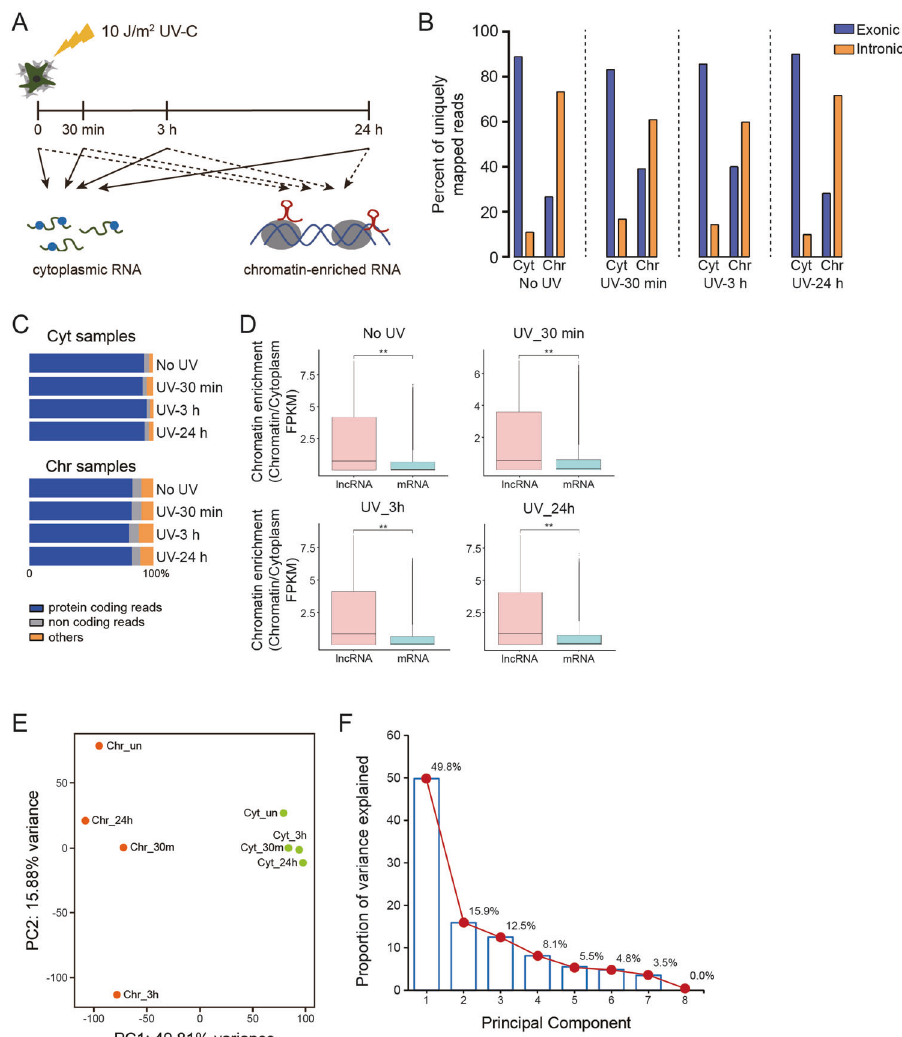
Fig. 2 Chromatin-associated nascent transcripts in response to UV-C are enriched by cellular fractionation. A Schematic illustration of the cellular fractionation procedure. Cytoplasmic extract and chromatin pellet extract were isolated from human fi broblasts in triplicates, and then pools from the respective fractionation were sequenced. B The percentage of RNA sequencing reads mapping to intronic and exonic regions for all samples. Cyt, cytoplasm; Chr, chromatin. C Biotype distribution of all the transcripts identi fi ed by RNA-seq analysis generated from cytoplasm or chromatin fractions annotated relatively to human hg38. D Fold chromatin enrichment analysis of the indicated RNA classes (chromatin FPKM/cytoplasm FPKM) for the untreated and UV-irradiated human fi broblasts. Boxes span the lower to upper quartile boundaries, median is presented with a black line, P values are calculated by student ’ s t test, ** P < 0.01. E Hierarchical clustering and PCA analysis of RNA- seq data from untreated and UV-irradiated MRC5_VA cells to separate all the samples into two groups. F The scree plot line indicates the amount of the total variance preserved by a principal